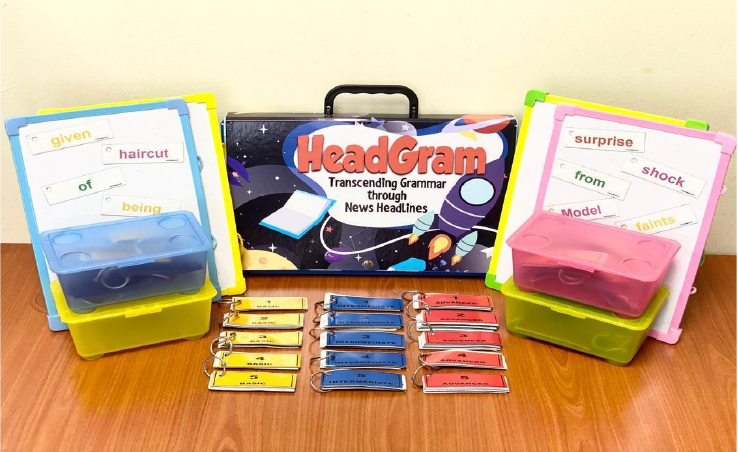
Figure 1 . Headgram set . Figure 1. Headgram